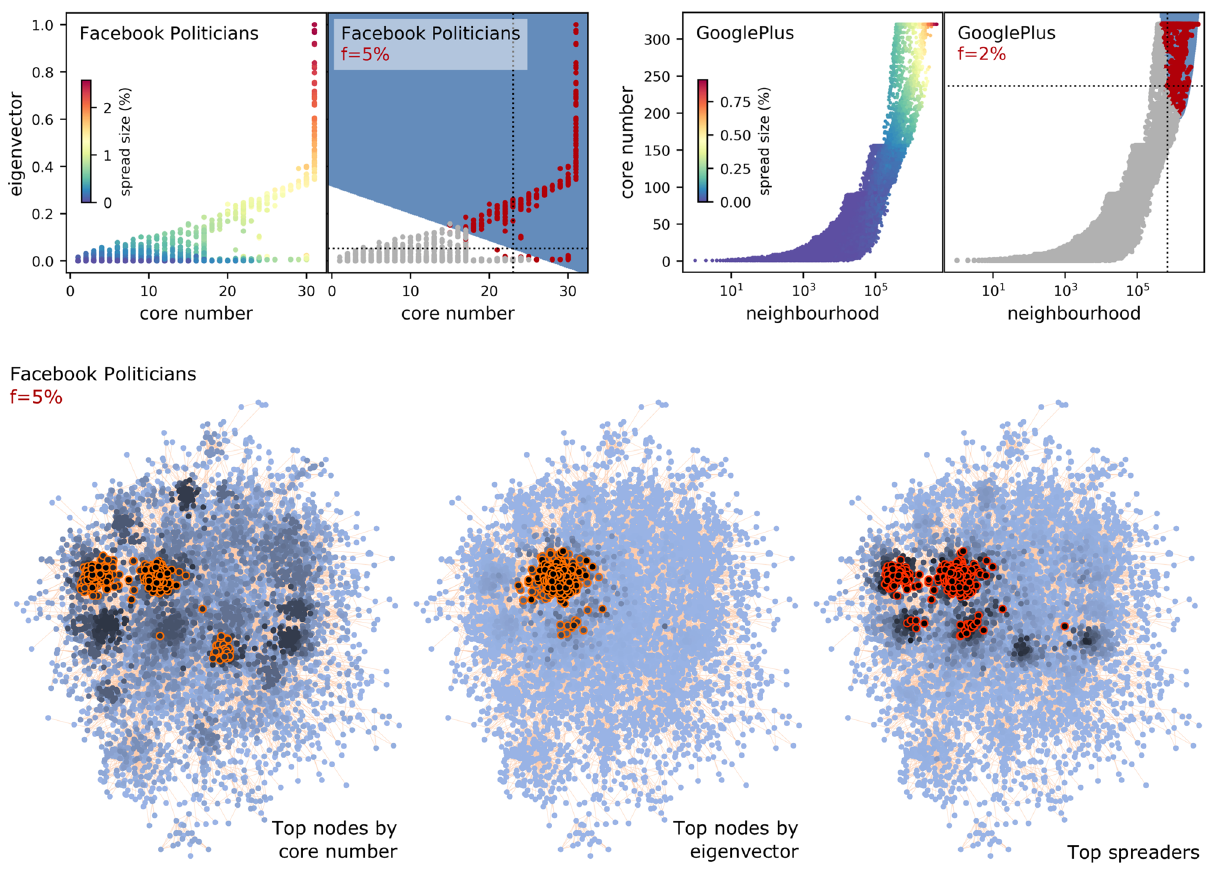
Figure 7. As Fig. 6, for core number combined with another centrality.